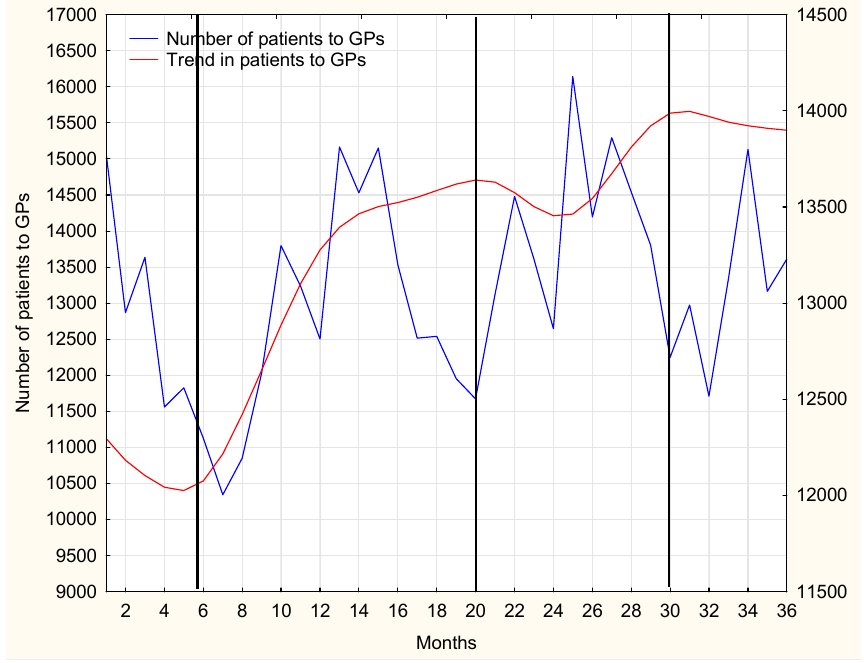
Figure 16. The number of the patients visiting the GP during the 36-month period, with a trend line.